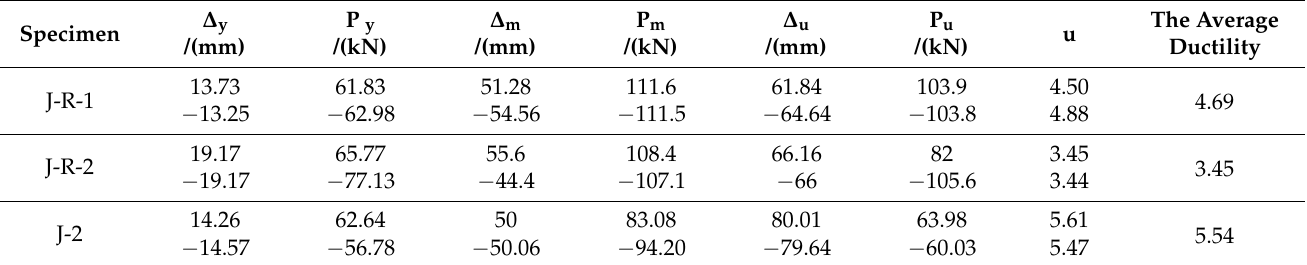
Figure 12. Skeleton curves of different specimens. Table 2. Characteristic values of the seismic performance of the